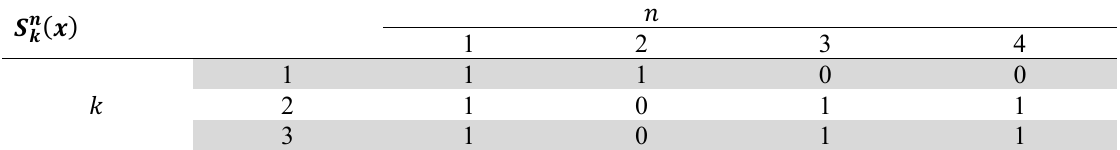
and (cid:1839) (cid:3041) (cid:3041)